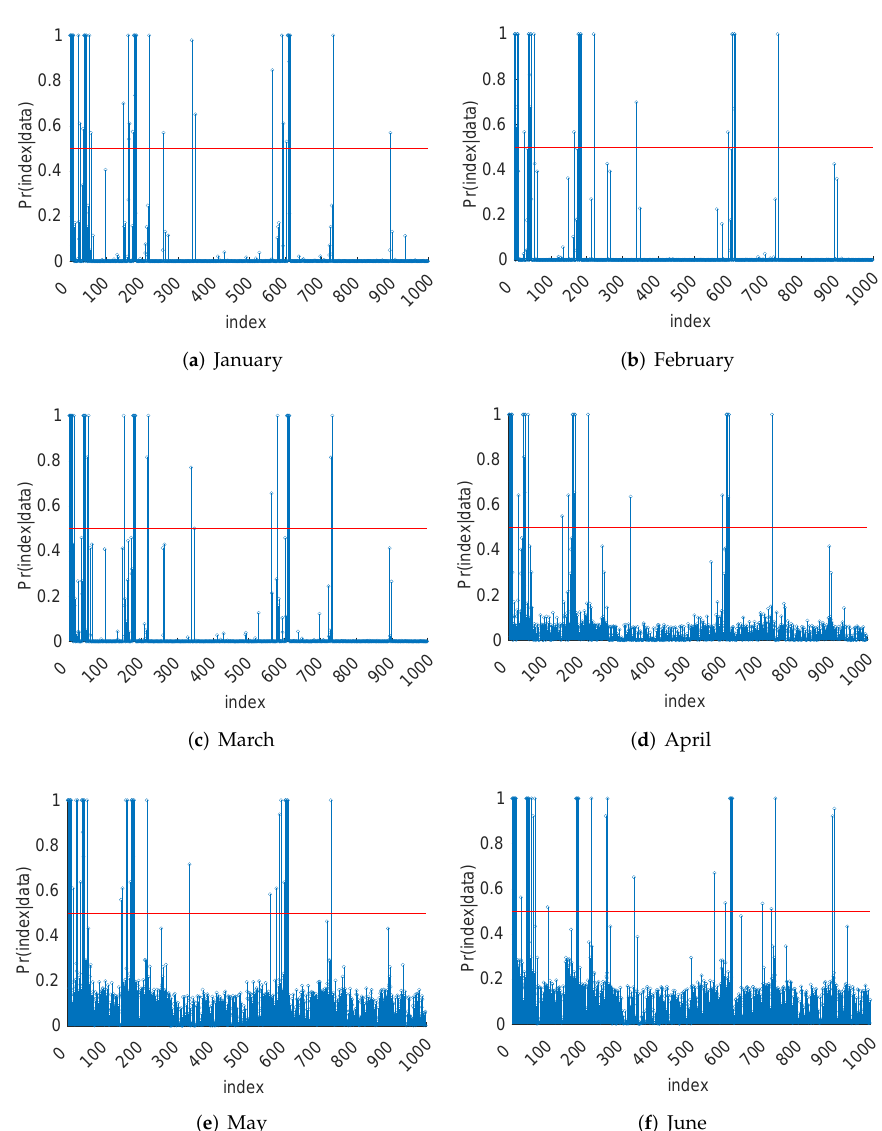
Figure 1. Plots of the posterior marginal inclusion probabilities: January–June.